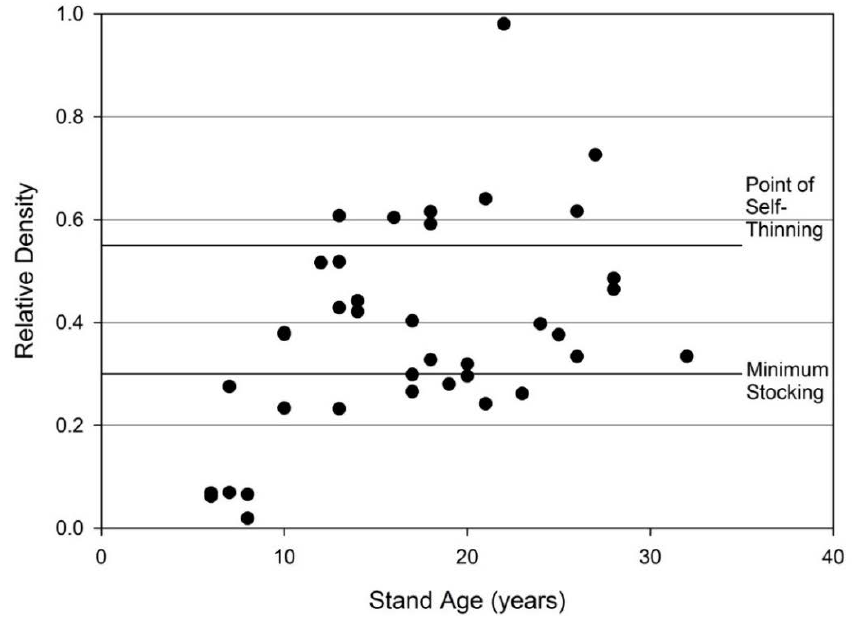
Figure 10. Stand density index calculated according to Doruska and Nolen [57]. Assumes maximum stand density index of 1100. Most stands on reclaimed mineland achieve minimum stocking, which results in similar productivity to unmined sites. Briefly, maximum SDI (stand density index) is the number of 25 cm DBH trees that could be grown per hectare at the biological carrying capacity of a species. Relative density is the proportion a stand’s observed SDI compared to maximum SDI for the species. Minimum stocking is the relative density at which a stand is fully occupying available growing